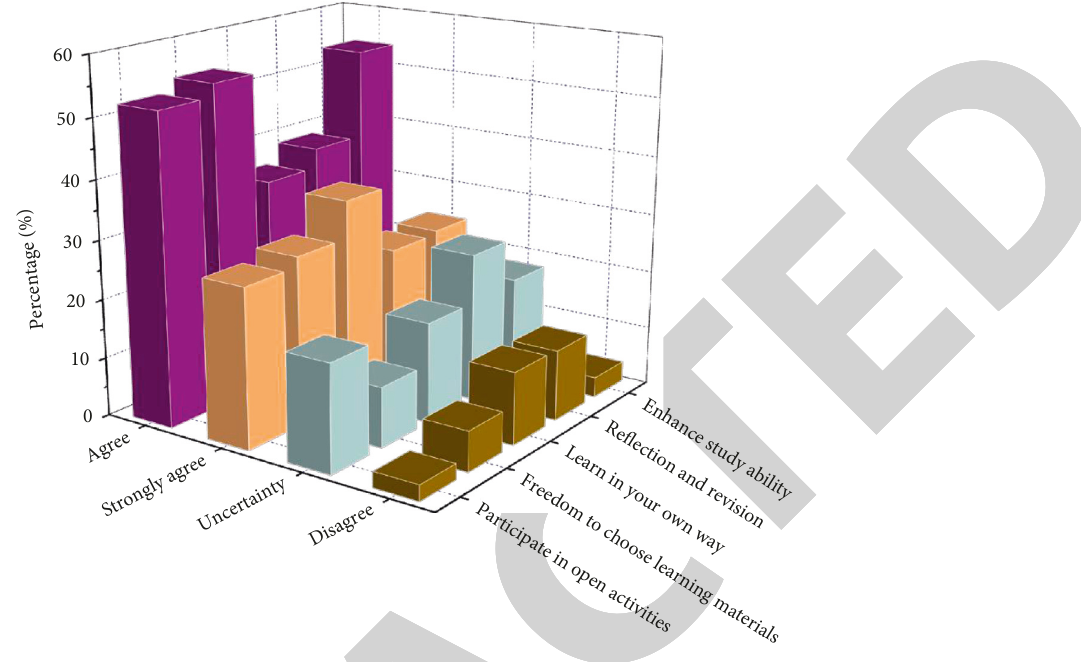
Figure 7: Evaluation of the promotion of autonomous